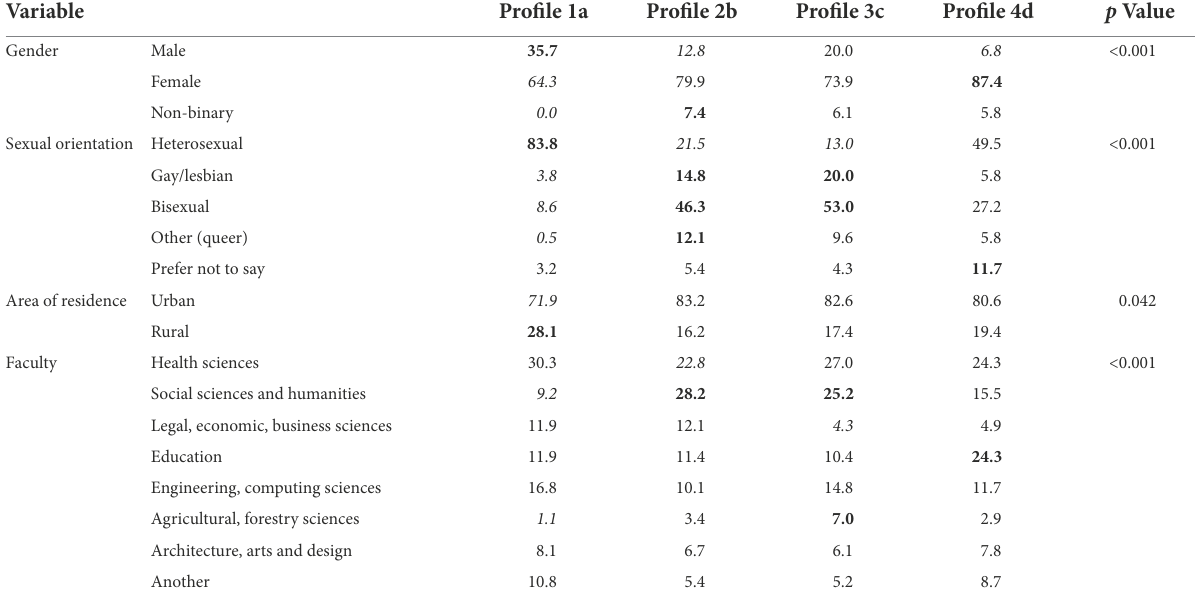
TABLE 5 Sociodemographic characteristics (%) with significant differences by